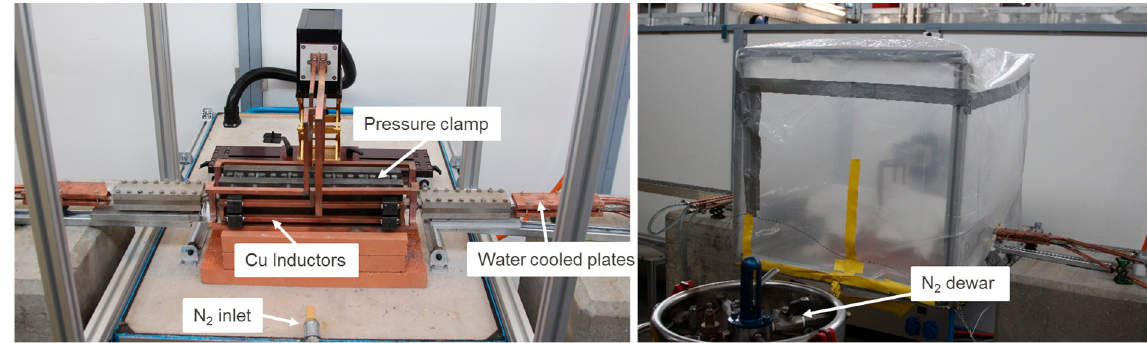
Figure 5. Diffusion bonding set-up during assembly ( left ) and during operation ( right ). Three types of samples were taken for the micrographic studies (Figure 6):